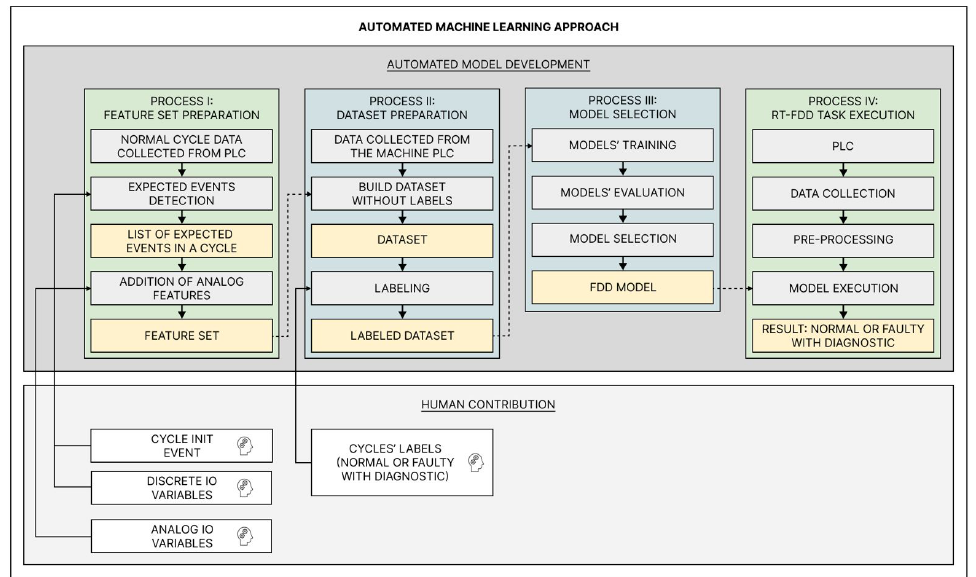
Figure 1. Flowchart of the proposed AutoML